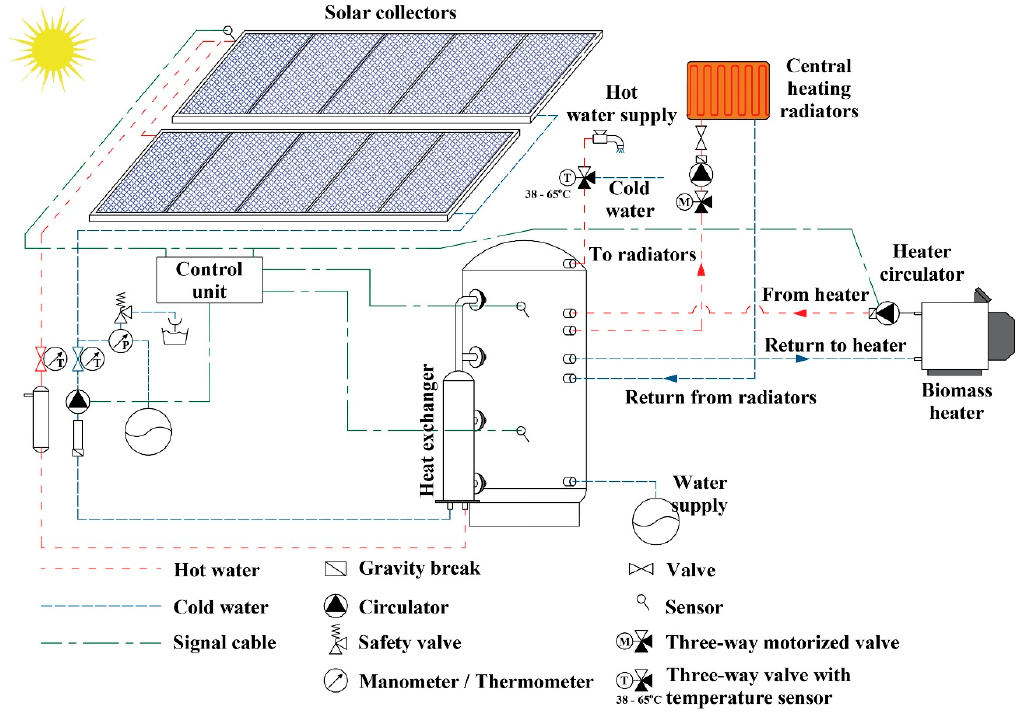
Figure 12. Construction and operation layout of the proposed solar-combi system.